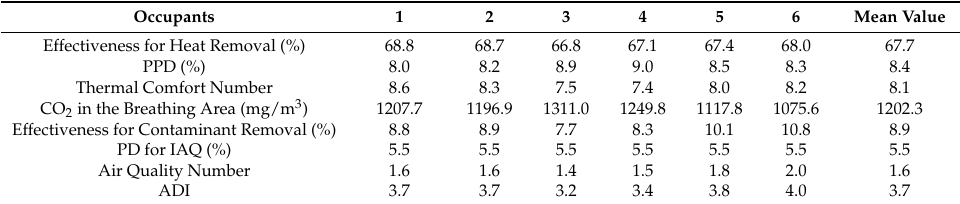
Effectiveness for Heat Removal (%)